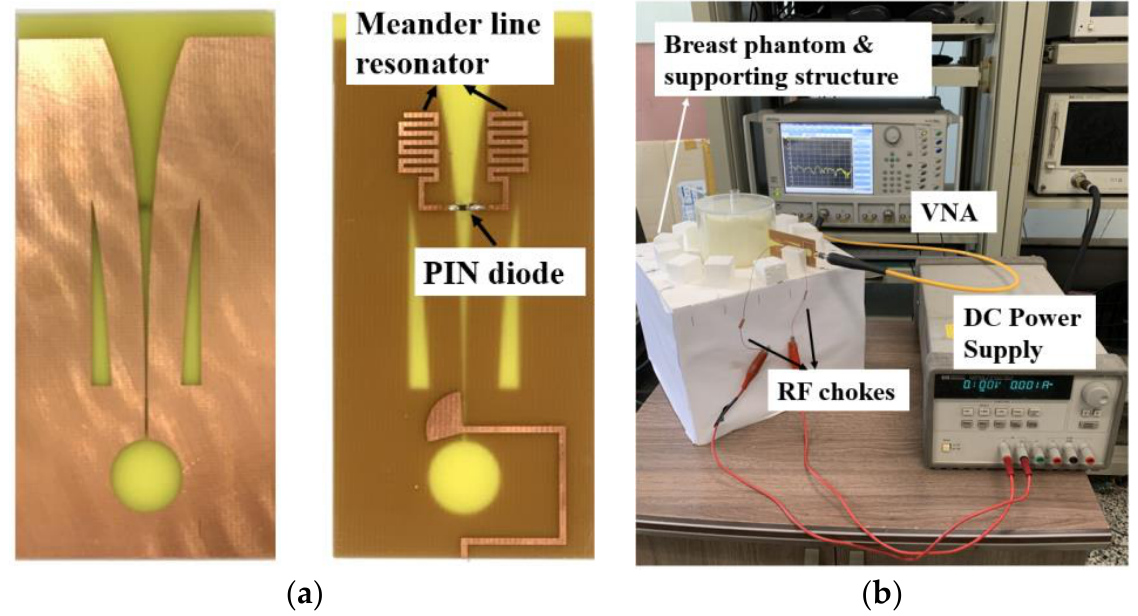
Figure 9. Fabricated frequency switchable TSA: ( a ) front and back, and ( b ) antenna measurement configuration with the fabricated breast phantom and supporting structure.